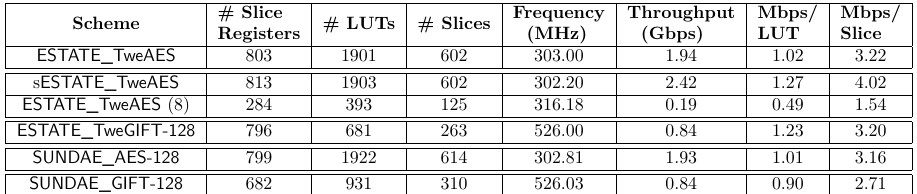
Table 7: ESTATE and SUNDAE (ED Circuit) Implemented FPGA Results